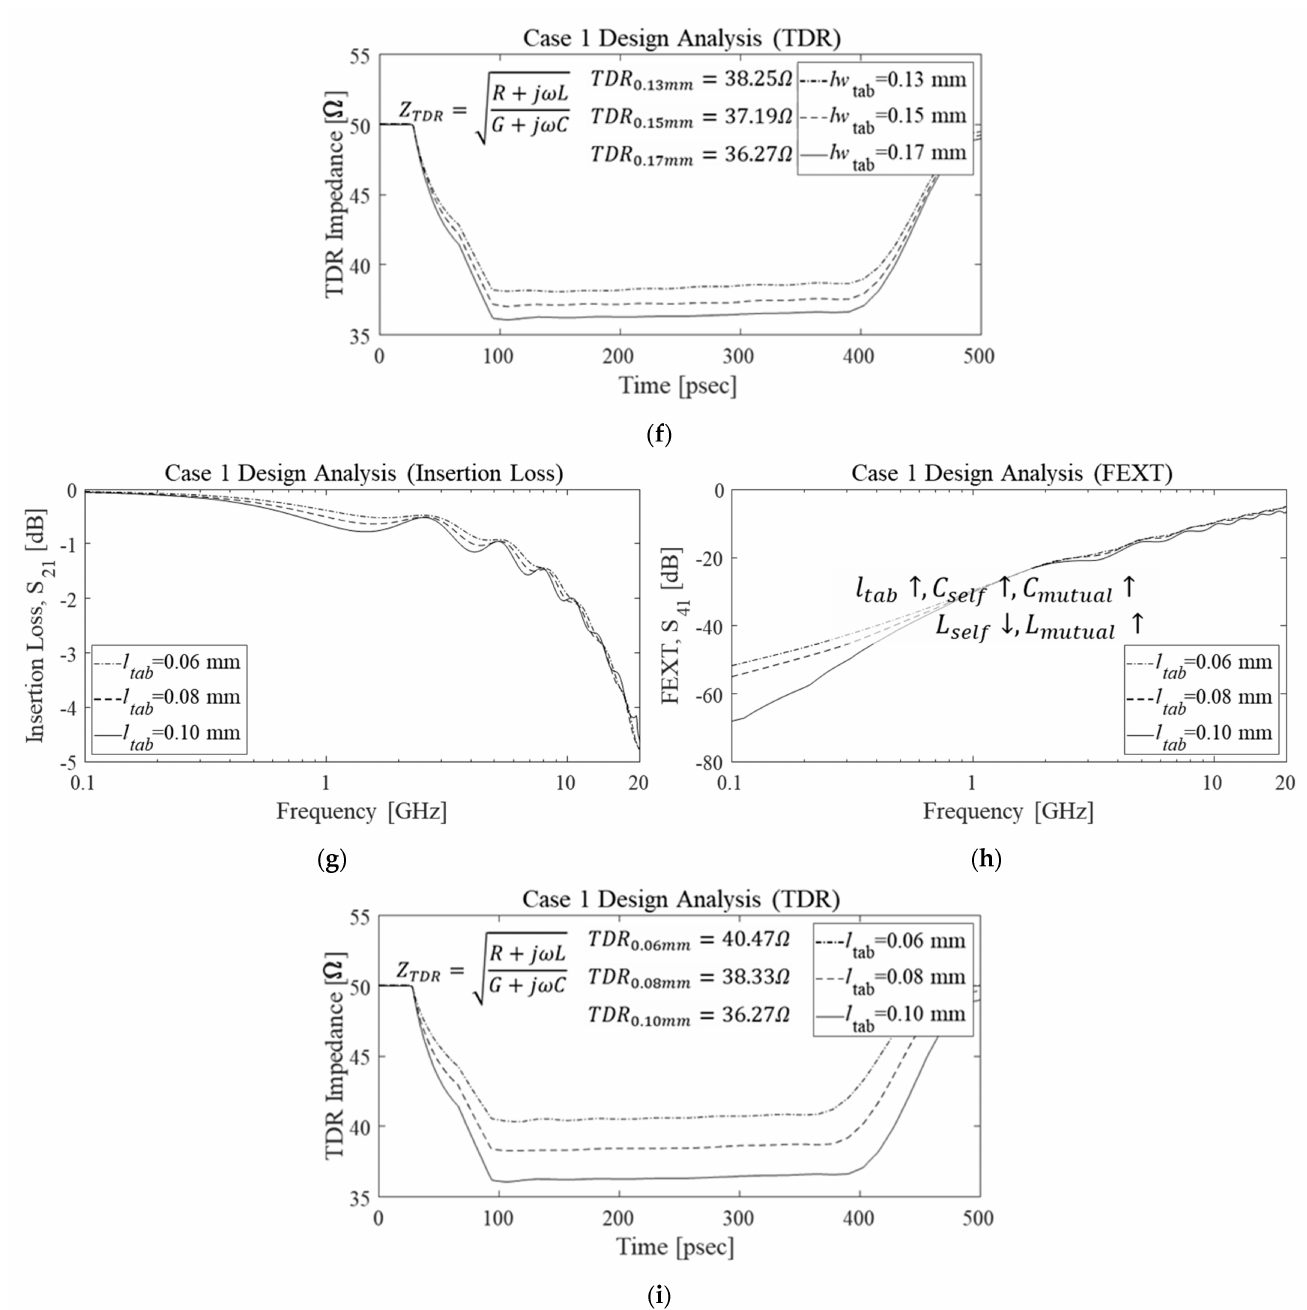
Figure 12. Results of frequency domain analysis of insertion loss and FEXT are shown with the variation of three tabbed routing design parameters. Comparison of ( a ) insertion loss, ( b ) FEXT, and ( c ) TDR impedance results for s tab variation. Comparison of ( d ) insertion loss, ( e ) FEXT, and ( f ) TDR impedance results for lw tab variation. Comparison of ( g ) insertion loss, ( h ) FEXT, and ( i ) TDR impedance results for l tab